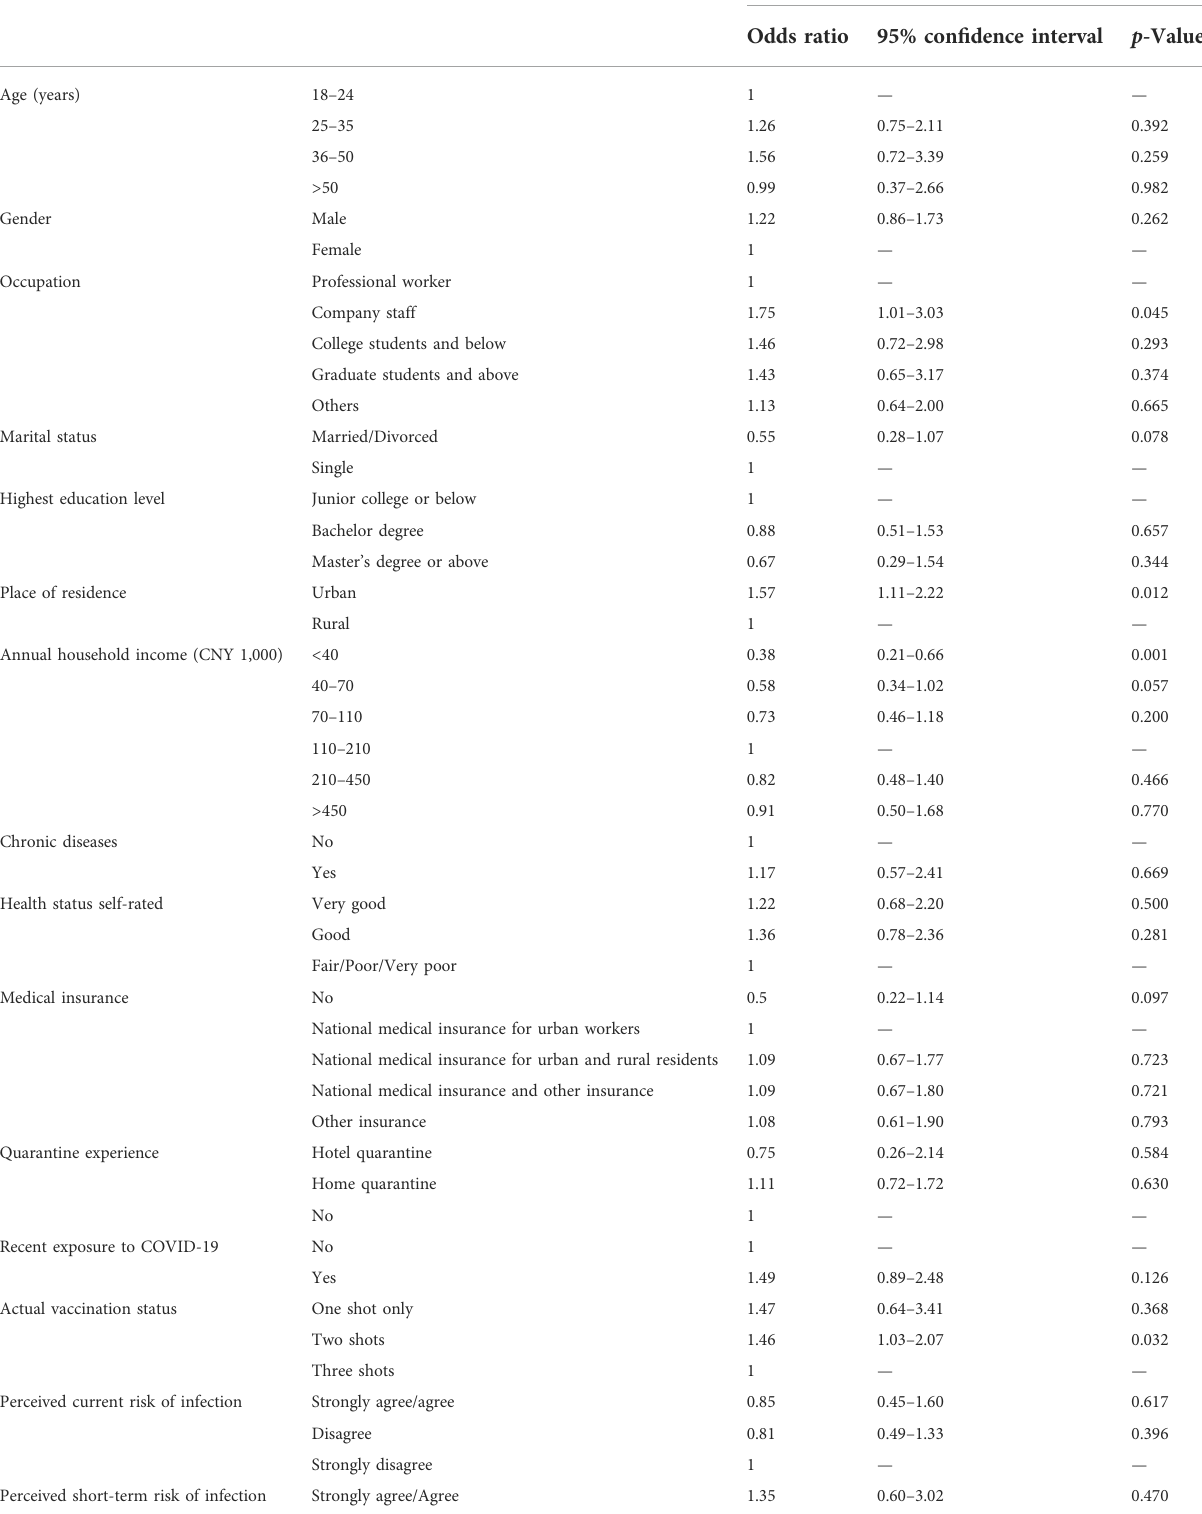
TABLE 3 Factors associated with the willingness to pay a high price for the COVID-19 vaccine booster